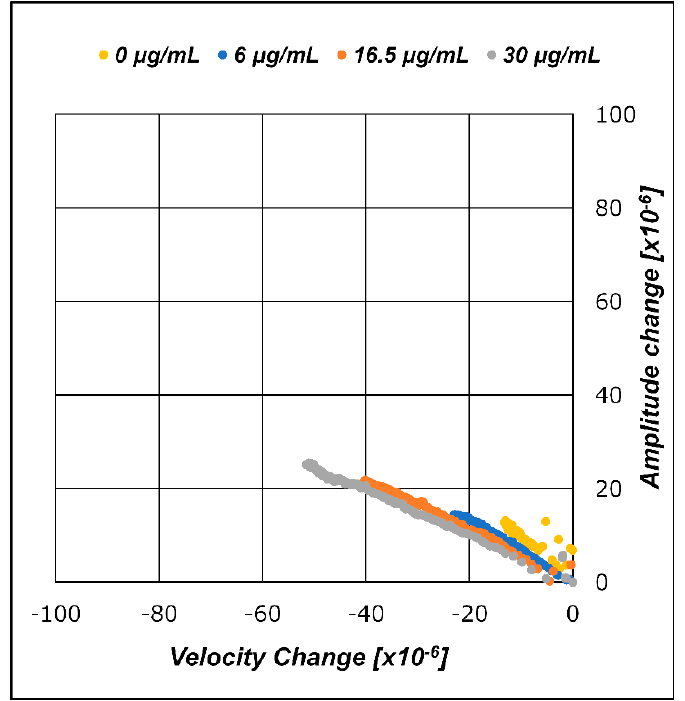
Figure 8. A/V plane plot for CRP molecule-binding step.